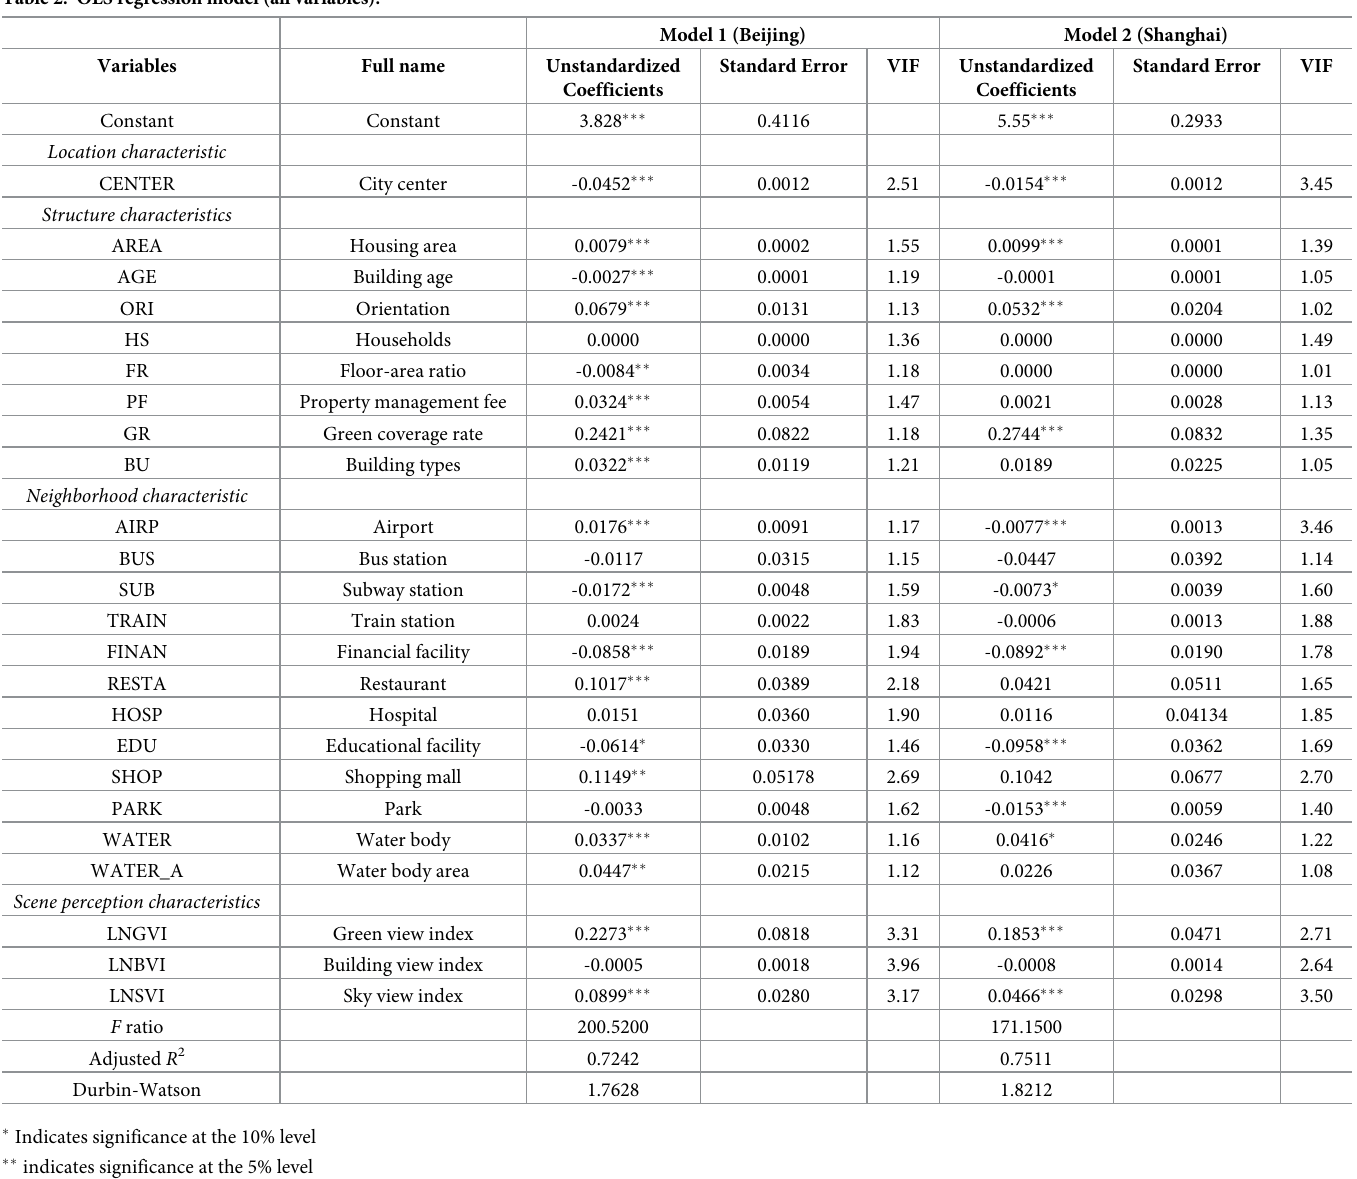
Table 2. OLS regression model (all